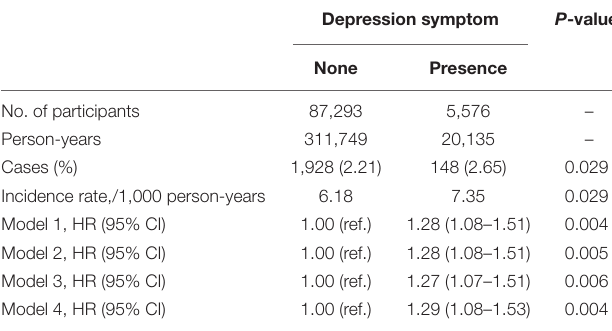
TABLE 2 | Association between depression status and major CVD